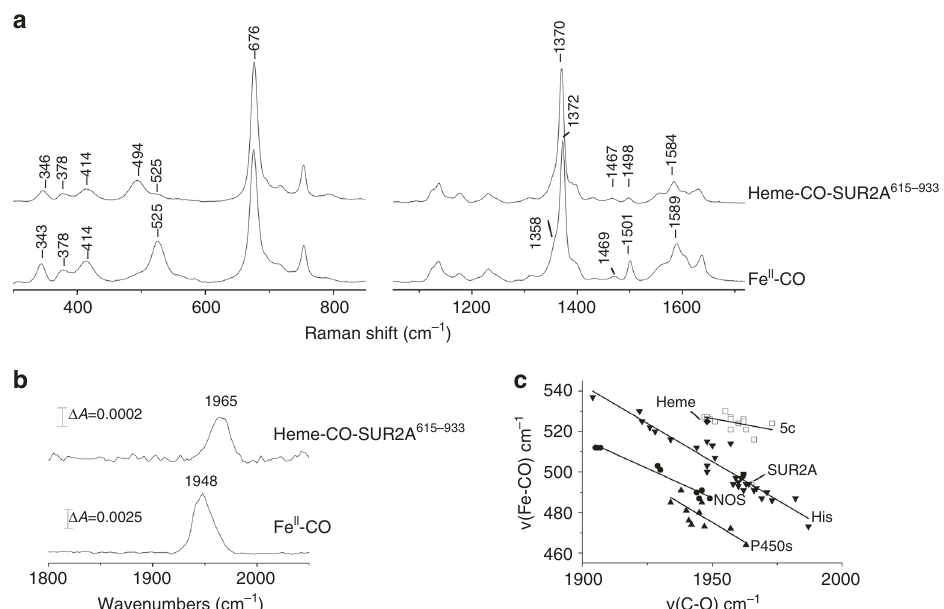
Fig. 3 Resonance Raman spectroscopy identi fi es the nature of the heme-CO-SUR2A complex. a Resonance Raman spectra in the high- and low-frequency of the CO-bound complexes of ferrous-heme and ferrous heme-SUR2A 615 – 933 , obtained with 413.1 nm excitation. b ATR (attenuated total re fl ection) infrared spectra of the CO-bound complexes of ferrous-heme and heme-SUR2A 615 – 933 in D 2 O in the 1750 – 2050 cm − 1 region. c A plot of v(Fe – CO) and v (C – O) stretching frequencies for the CO complexes of various heme proteins and model compounds with different axial ligation. All entries in this plot were created from the data presented in Supplementary Table 5; data obtained for model compounds are shown as squares, for histidine-ligated heme proteins are shown as inverted triangles, for nitric oxide synthases are shown as circles, and for P450s are shown as triangles. SUR2A 615 – 933 (indicated as un fi lled diamonds) and free heme (indicated as diamonds) lie on the correlation line that is characteristic for histidine-ligated heme proteins (inverted triangle) and 5-coordinate model compounds with no trans ligands or 6-coordinate heme species with weak trans ligands (square),